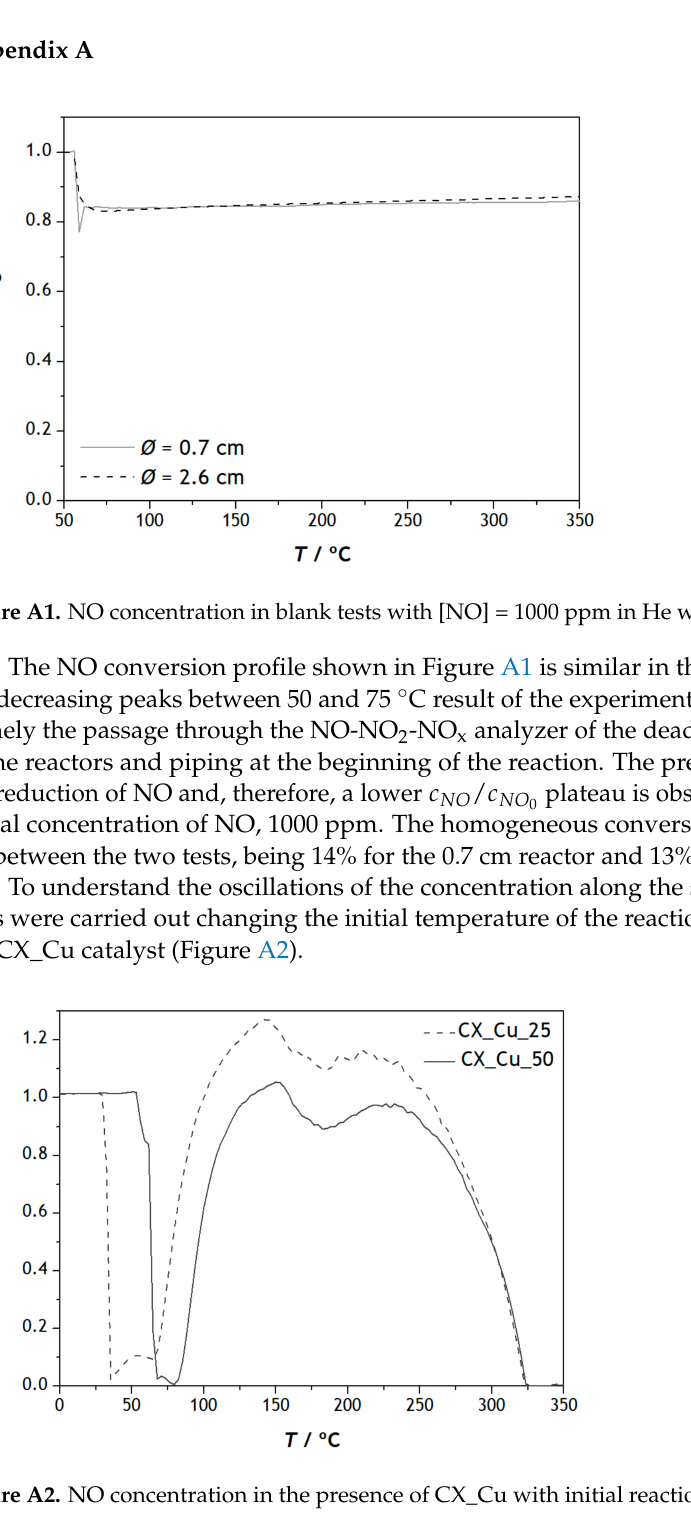
Figure A2. NO concentration in the presence of CX_Cu with initial reaction temperature of 25 and 50 ◦ C and [NO] = 1000 ppm in He with 5% of O 2